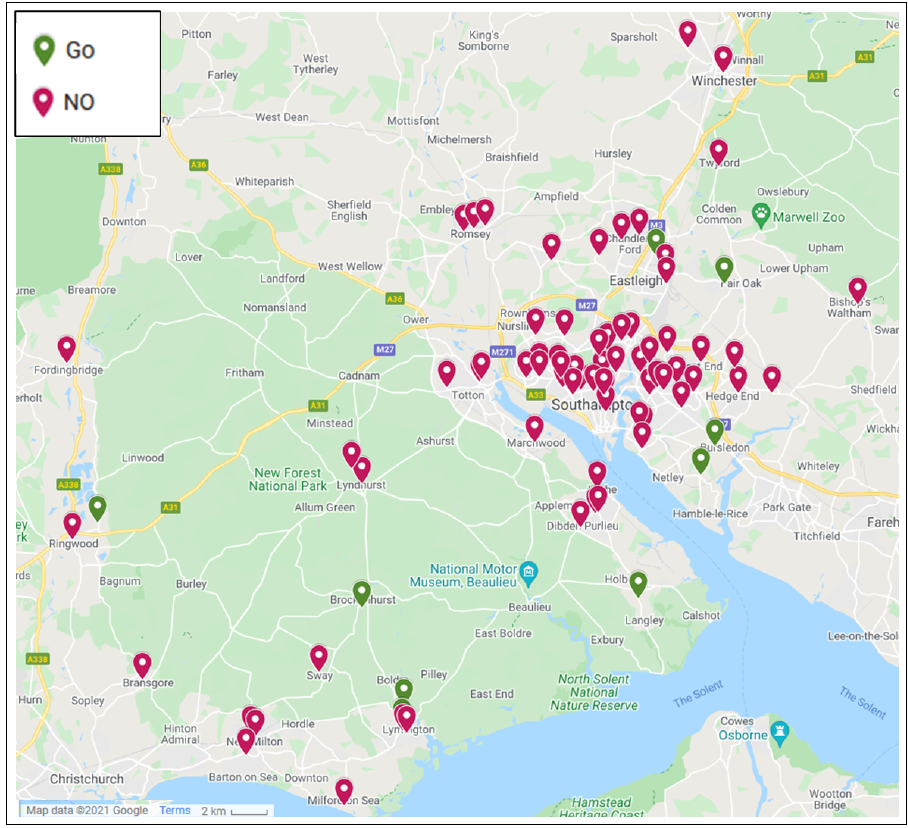
Figure 1. Sites tested and excluded from the analysis in the Southampton area. Go indicates the site was included for service by